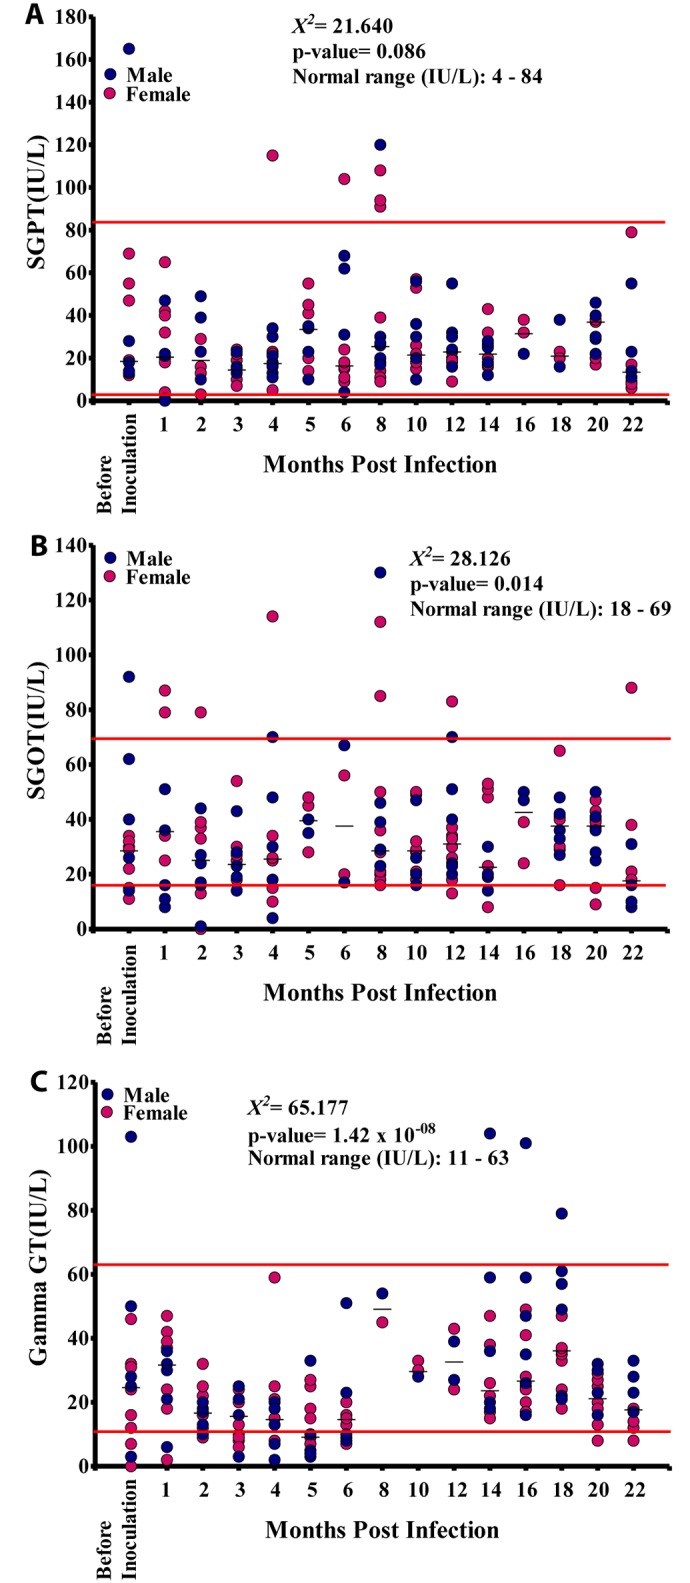
Enzyme levels in the 15 baboons infected with Loa loa.A. Serum glutamic pyruvic transaminase (SGPT) levels. B. Serum glutamic-oxaloacetic transaminase (SGOT) levels. C. gamma-glutamyl transferase (GGT) levels.